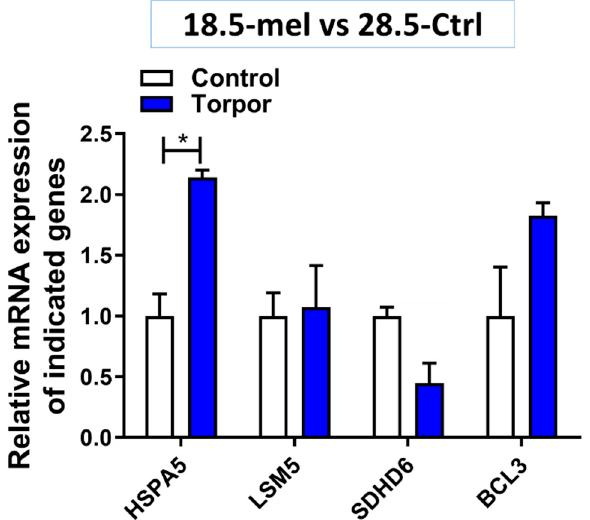
Figure 3. Gene expression in the torpor (18.5-mel) group compared to that in the control (28.5-Ctrl) group. The figure shows the relative increase in expression of HSPA5 ( p = 0.013) and while not significant BCL3 expression ( p = 0.107) is also increased. It also demonstrates an almost significant decrease in expression of SDHD6 ( p = 0.05) compared with control, supporting the results from DE analysis. * p <